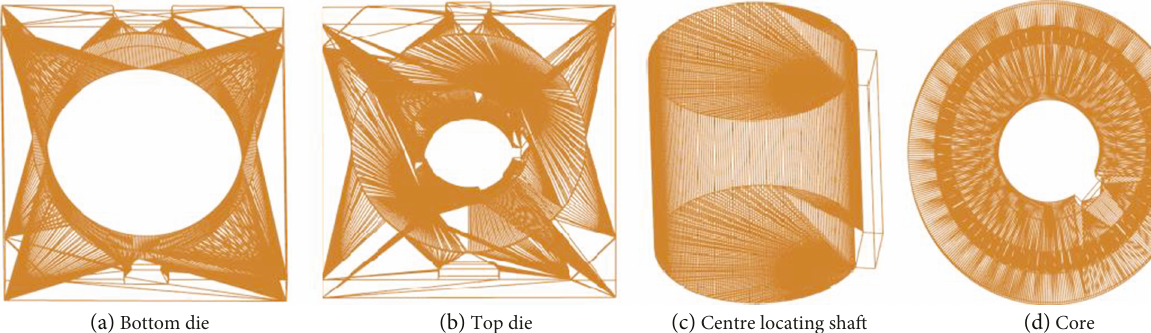
Figure 5: The STL model of the spur face gear master mould.